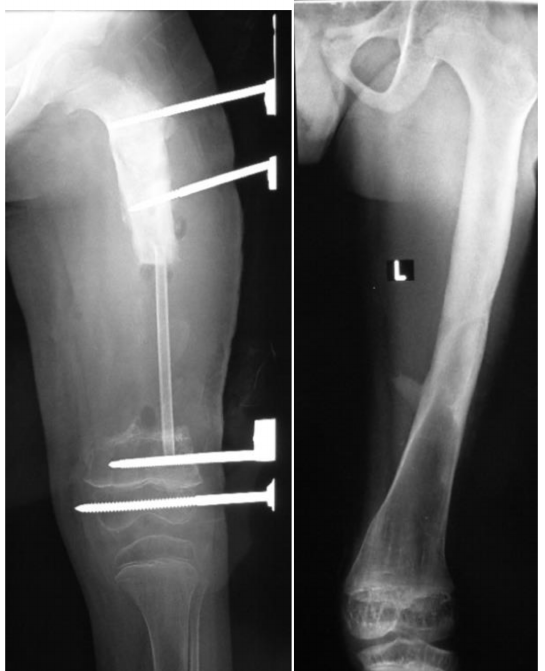
Table 4. Donor site complications following VFF.